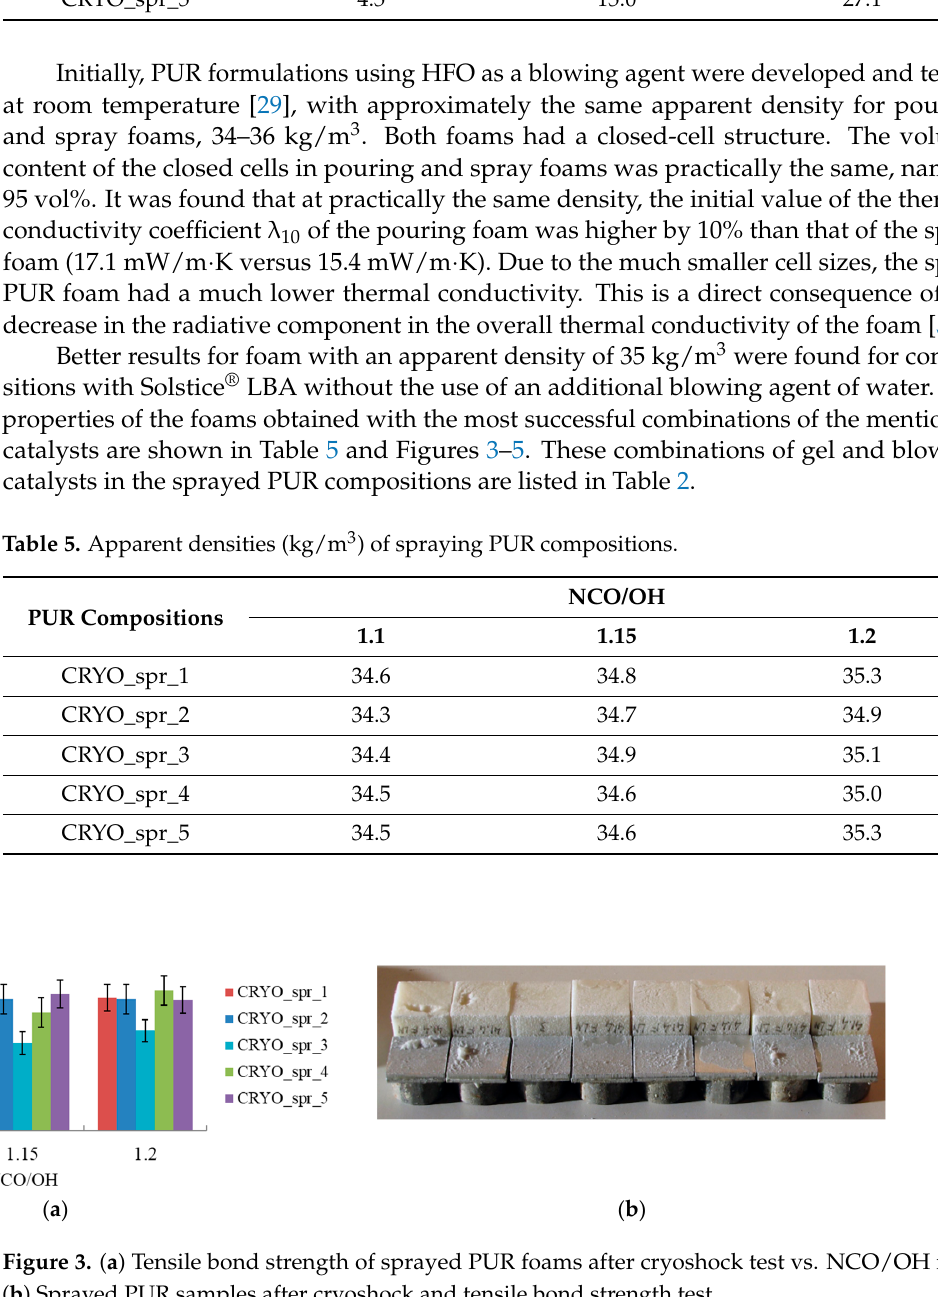
( b ) Figure 4. PUR foam tensile properties at 77 K vs. NCO/OH ratio: ( a ) tensile strength; ( b ) elongation at break. PUR foam elongation at break at 77 K, like tensile strength, mostly, with rare exceptions, increased with increasing isocyanate index for all compositions (Figure 4b). The highest elongation values were found for CRYO_spr_1 with the conventional catalysts Kosmos 19 and Polycat 5. However, the elongation of CRYO_spr_4 with 0.2 pbw of the catalyst MB-20 and 6 pbw of the catalyst Polycat 218 is only slightly inferior.